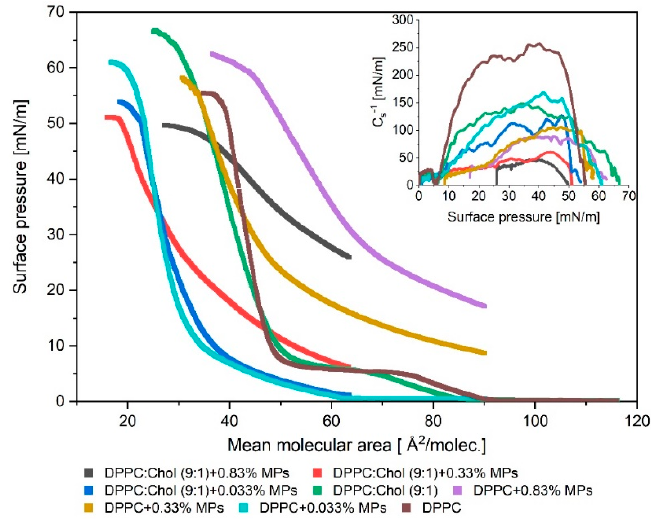
Figure 1. π –A isotherms of Langmuir monolayer for DPPC and DPPC:Chol (9:1) with different concentration of MPs; the inset graph presents surface compressional modulus C s − 1 vs. surface pressure, π . The addition of Chol to the DPPC monolayer caused a slight shift in the π− A isotherm position toward lower mean molecular area values. The lift-off area of the DPPC mono- layer was ca. 88 Å 2 /molec., while for DPPC:Chol (9:1) it was ca. 84 Å 2 /molec. The presence